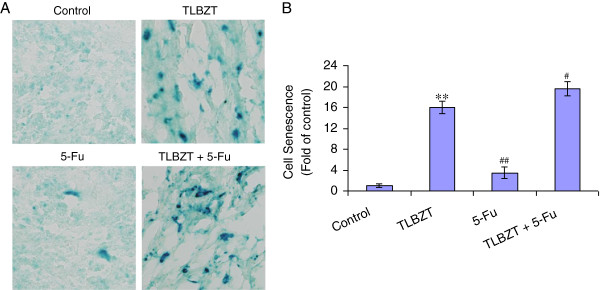
Effects of TLBZT and 5-FU on cell senescence in CT26 carcinoma. A, after three weeks treatment, CT26 carcinomas (3 tumors/group) were removed and frozen cut into 7μm sections, fixed, reacted with SA-β-gal staining solution overnight and observed under microscope (×200). B, SA-β-gal positive staining was counted in 3 HPF in each slide and expressed as fold over control. **P<0.01, versus control group, ##P<0.01, versus TLBZT group, #P<0.05, versus TLBZT group.